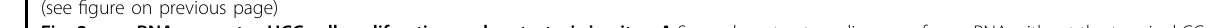
Fig. 2 mascRNA promotes HCC cell proliferation and metastasis in vitro. A Secondary structure diagram of mascRNA without the terminal CCA (mascR-58, 58nt) and mature mascRNA containing CCA (mascR-61, 61nt). B Sequences of mascRNA-58nt and mascRNA-61nt. C GFP fl uorescent signals of HepG2 and Bel7402 cells with control/oe-mascR-58nt/oe-mascR-61nt lentivirus infection. Scale bar represents 100 μ m. D The expressions of mascRNA in HepG2/Bel7402 + control/oe-mascR-58nt/oe-mascR-61nt stable cells were measured by real-time RT-PCR. E The effect of mascRNA overexpression on cell proliferation was detected by colony formation assay. 1000 HepG2 or Bel7402 stable cells were seeded for each well in 12-well plate. Colonies were stained with 0.1% crystal violet. Wound healing assays were performed in ( F ) HepG2 and ( G ) Bel7402 stable cell lines. Movement of cells into wound was shown at 0 h (Scale bar represents 100 μ m and 48 h (Scale bar represents 200 μ m post scratch. Cell migration was assessed by recover of the scratch. H Transwell matrigel invasion assay showing the effect of mascRNA overexpression on the invasive activity of HepG2 or Bel7402 stable cells. Scale bar represents 200 μ m. I The graphics presents the number of invaded cells, normalized to the control group. Quantitative data were represented as mean ± SD. * P < 0.05, ** P <